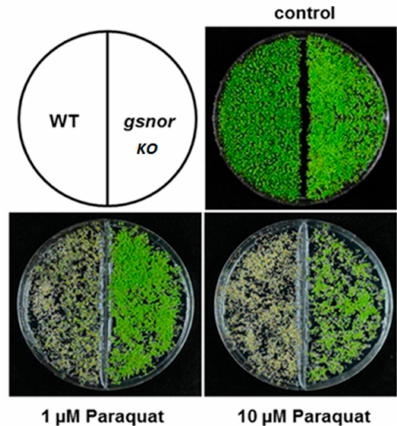
Figure 5. GSNOR knock out has innate resistance to an oxidative environment in Arabidopsis [38]. The upper left image displays the organization of the dish containing sprouted seeds with WT GSNOR on the left and the GSNOR knock out on the right. The bottom images display that with increased concentration of the herbicide, paraquat, which acts through creating a highly oxidative environment there is obvious native resistance in the GSNOR knock out